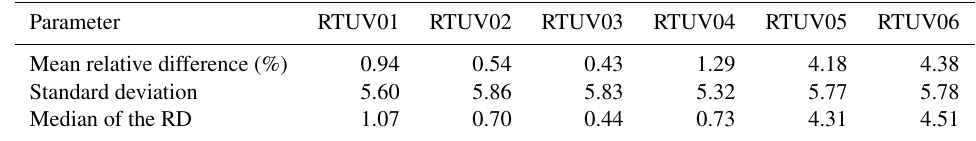
Table 4. RTUV Cases against clear-sky UVI observations.